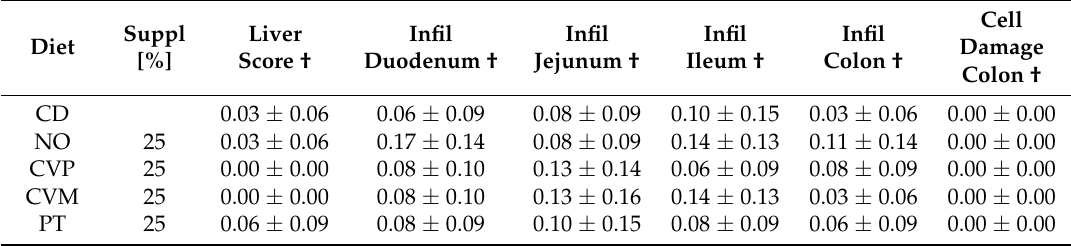
Table 4. Histological scores of liver and gastrointestinal tracts in C57BL/6J mice after 14 days diet consumption. Data are expressed as mean ± SD ( n = 4–6).